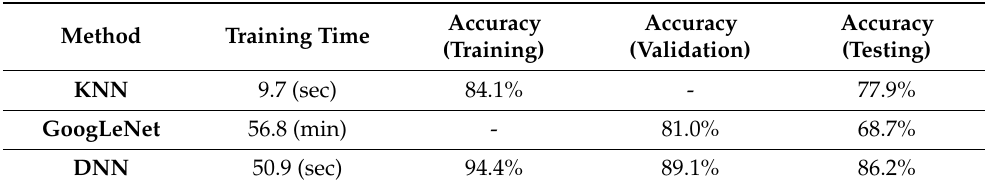
Table 10. Comparison of accuracy between KNN, GoogLeNet, and the proposed approach with rotation 40%, FM-10%, and